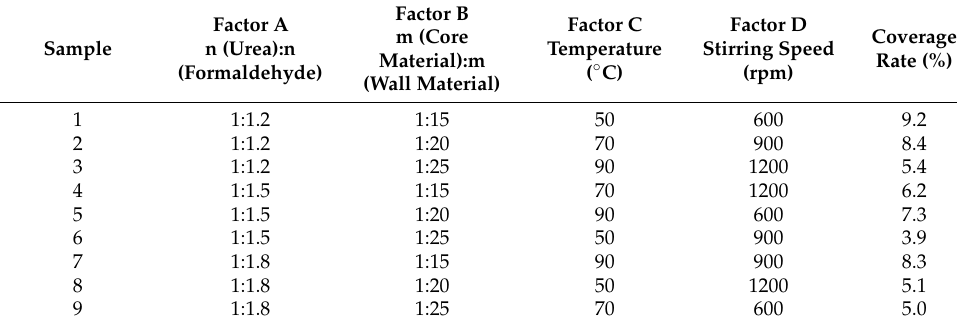
Table 9. Analysis of microcapsule coverage rate